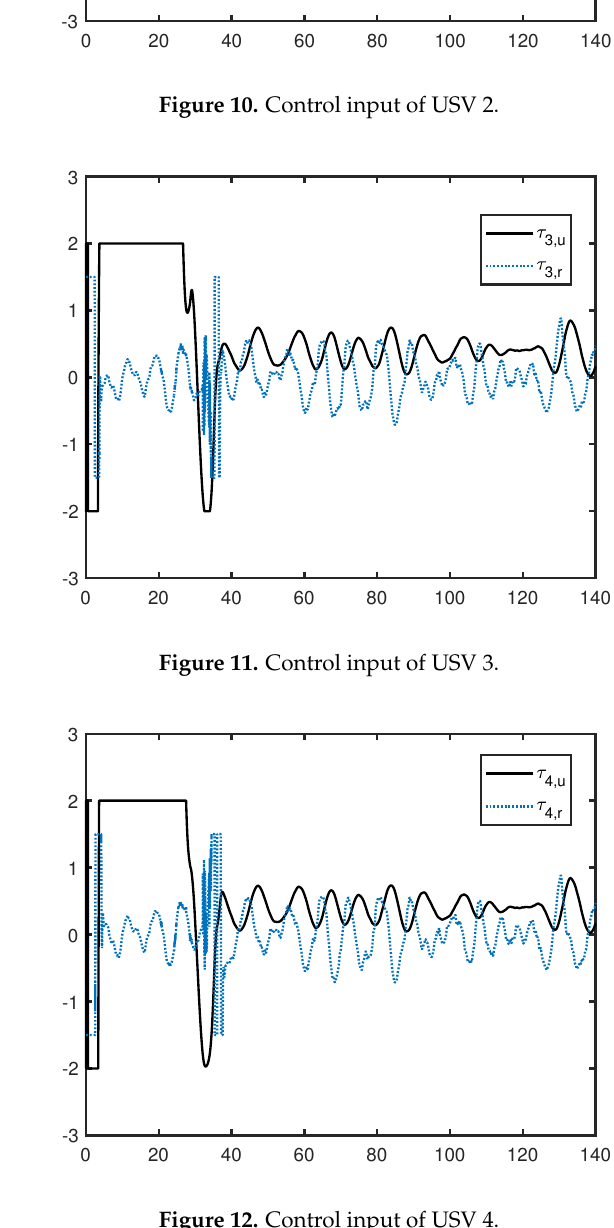
Figure 12. Control input of USV